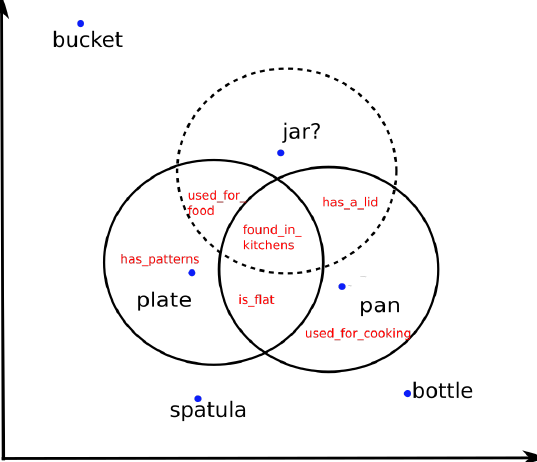
Figure 1. Inferring properties of “jar” from known properties of “plate” and “pan” based on distributional semantic